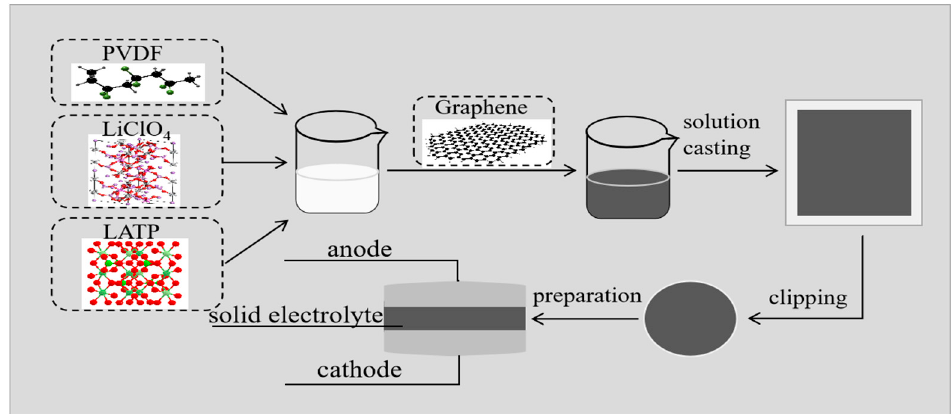
Figure 1. Schematic diagram of the preparation of the poly (vinylidene fluoride)-Li 1+x Al x Ti 2 − x (PO 4 ) 3 - LiClO 4 -Graphene (PLLG) composite solid electrolyte.